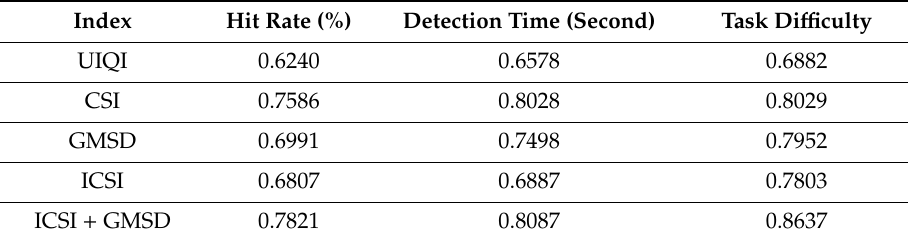
Table 1. Pearson correlation coefficients of the camouflage effectiveness evaluation methods for various performance parameters.